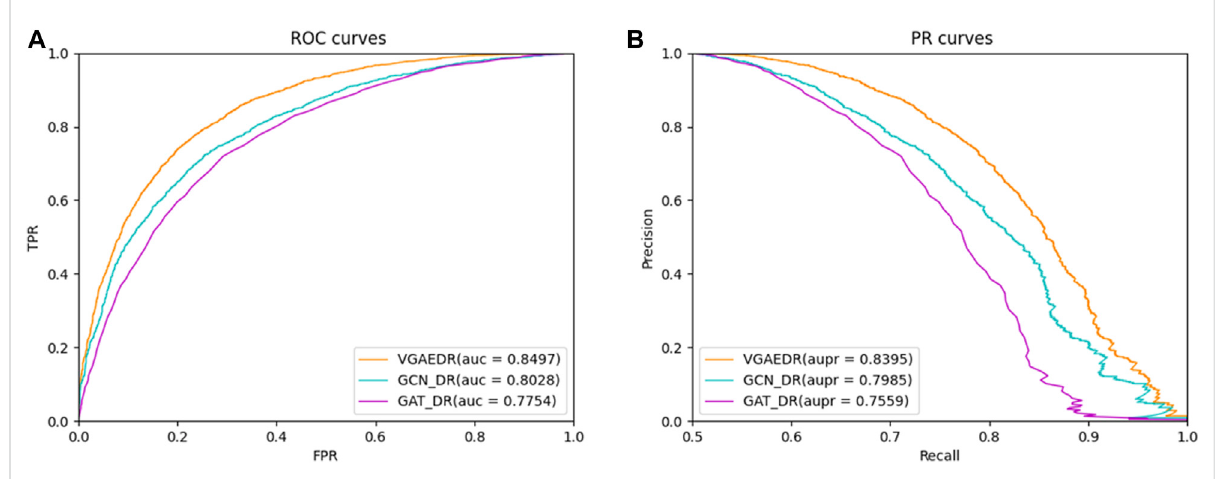
FIGURE 6 (A) The ROC curves of different graph representation learning, (B) The PR curves of different graph representation learning.